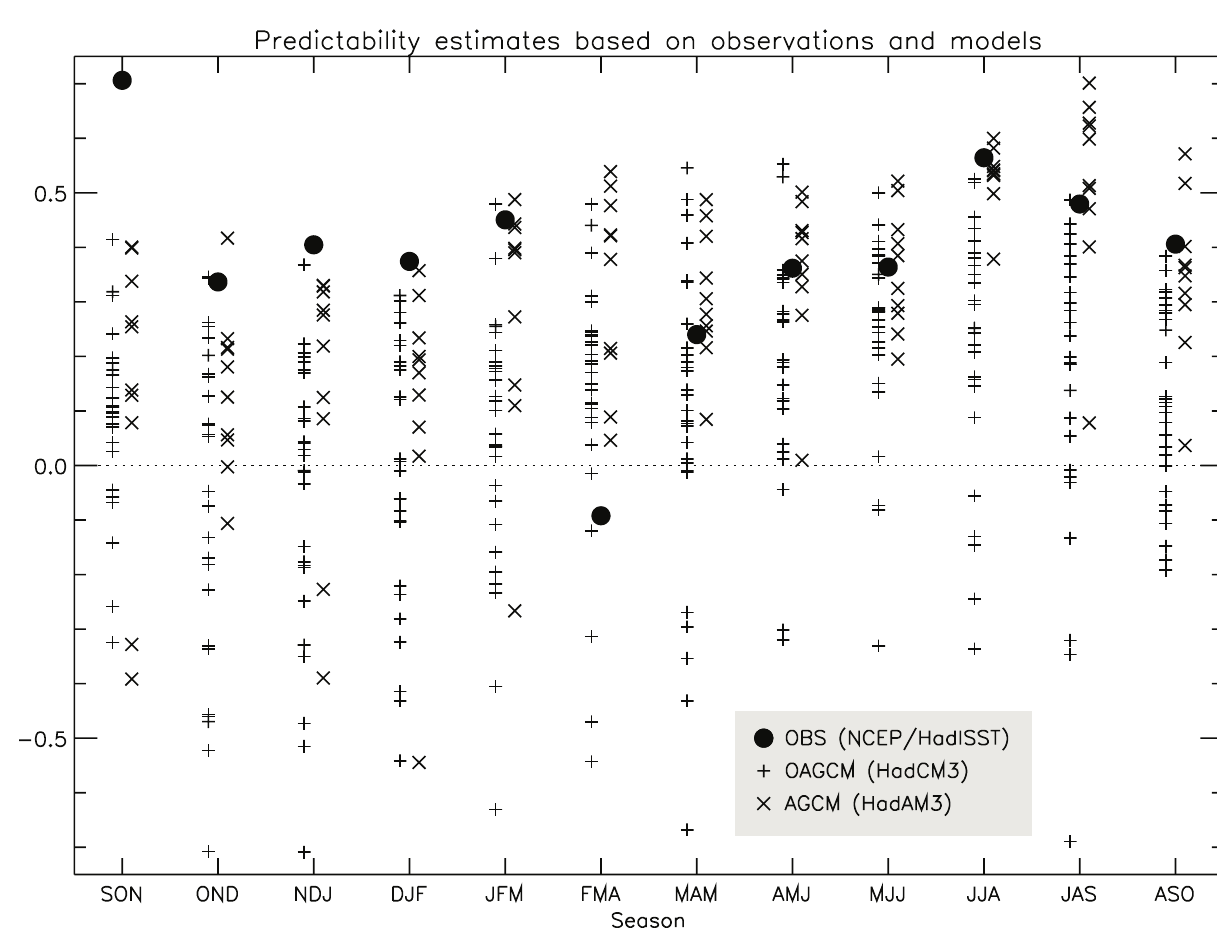
Fig. 3. Cross-validated correlations (CORs) obtained from the observations (circles), OAGCM (plus signs) and AGCM (diagonal cross crosses) when SSTs lead Z500 by two